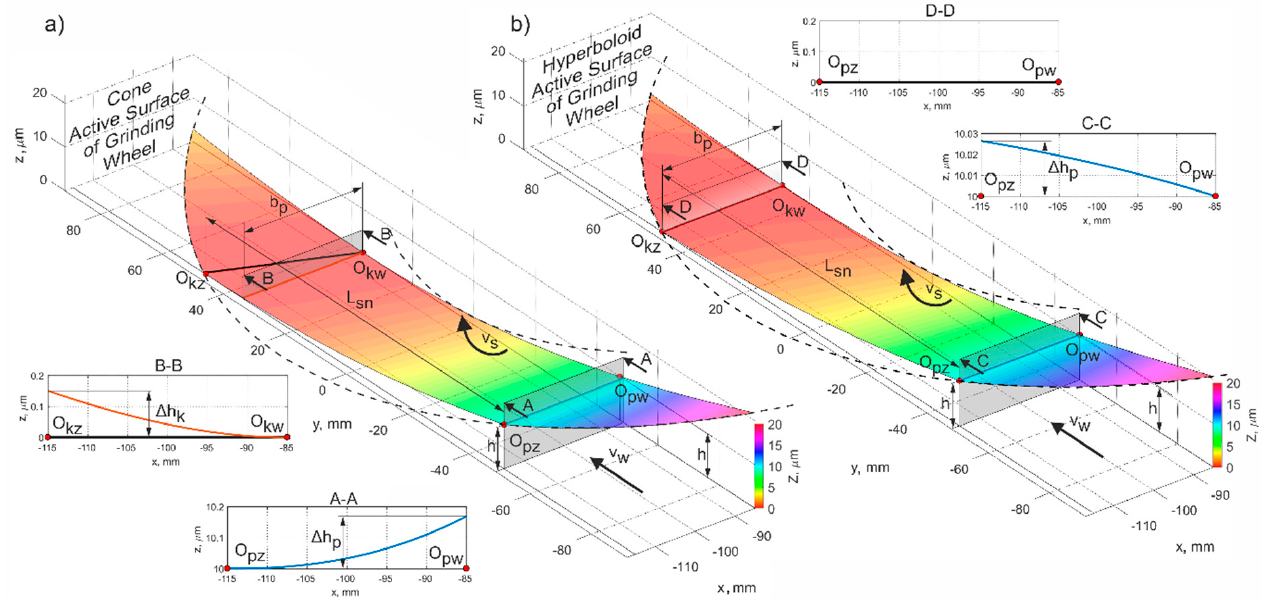
Figure 3. Geometric model of the active surface fragment of the grinding wheel with a conical ( a ) and a hyperboloidal ( b ) shape. L sn —contact length; b p —workpiece width; v w —feed rate; v s —grinding speed; h —depth of cut; Δ h p —difference of the removed allowance in the initial grinding zone; Δ hk —difference of the removed allowance in the grinding end zone; O pw and O pz —internal and external point of the start of the grinding zone, respectively; O kw and O kz —inner and outer point of the grinding zone end, respectively.